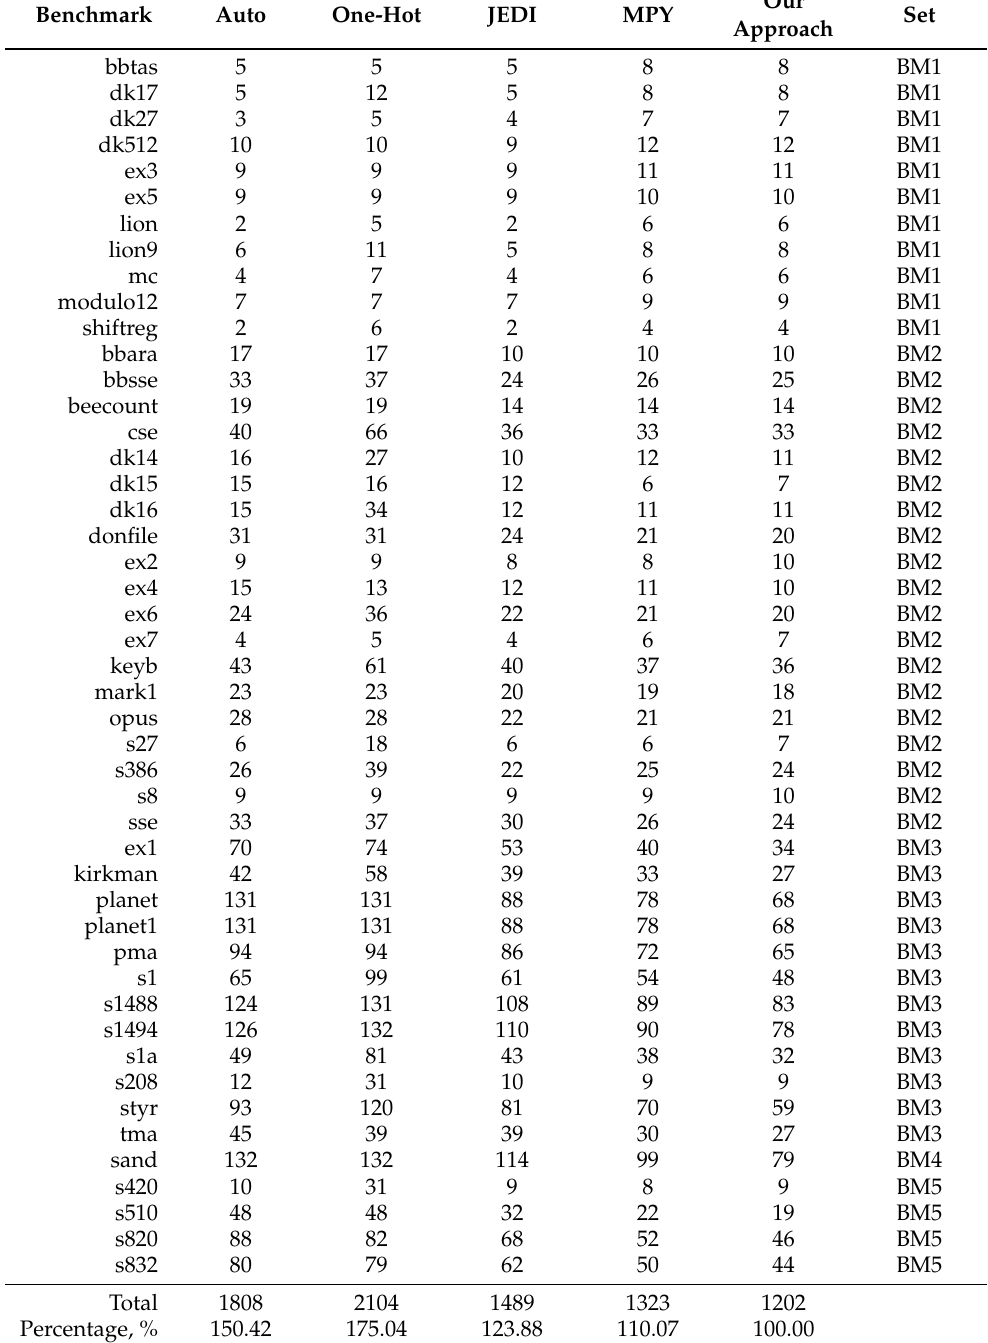
Table 9. Experimental results (numbers of LUTs for